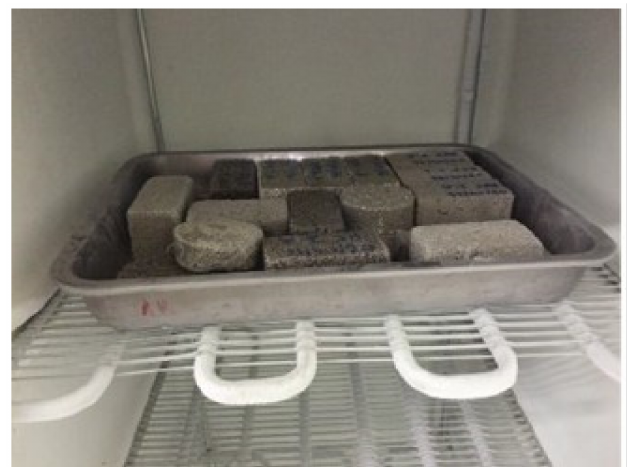
Figure 11. Freezer at − 15 ± 1 ◦ C.